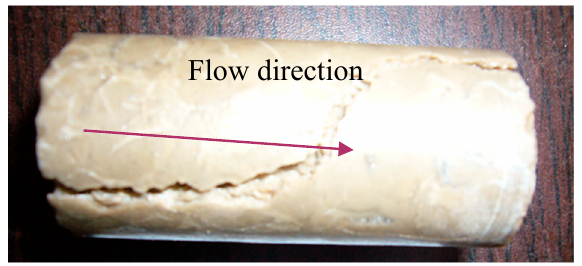
Figure 9. Morphology of sample 13 after acid fracturing.